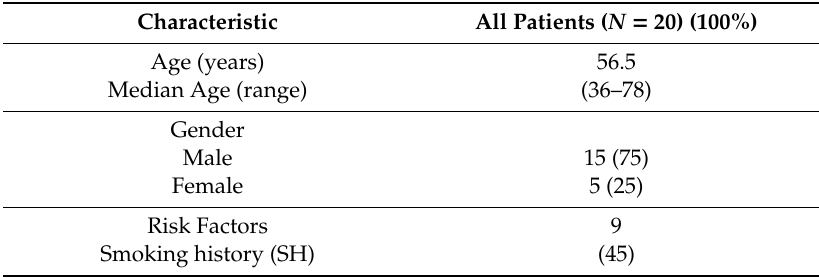
Table 1. Clinical and pathological characteristics and